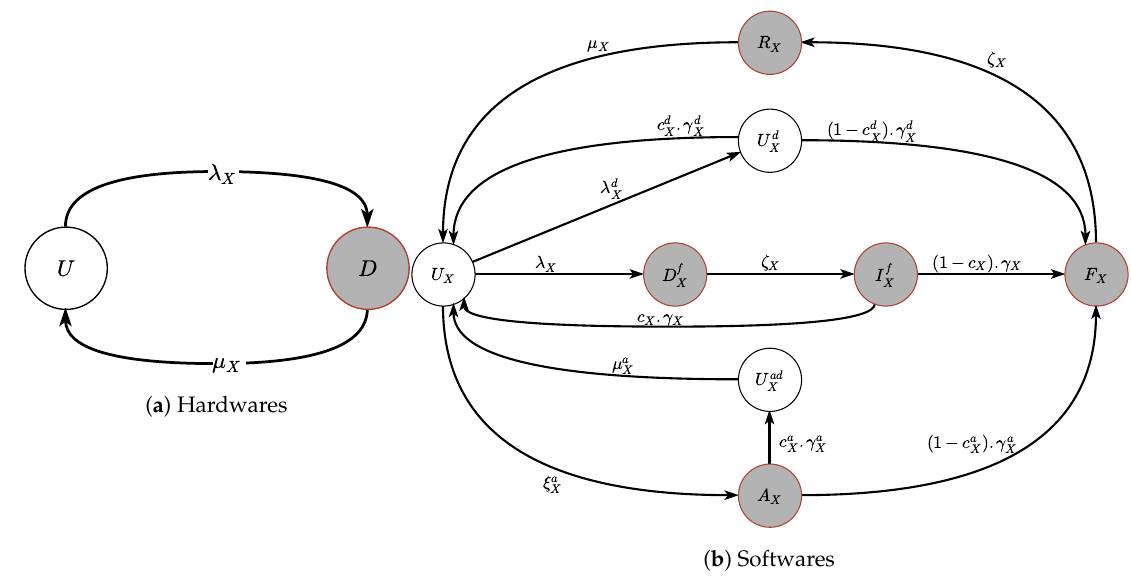
Figure 5. Submodels of hardware/software